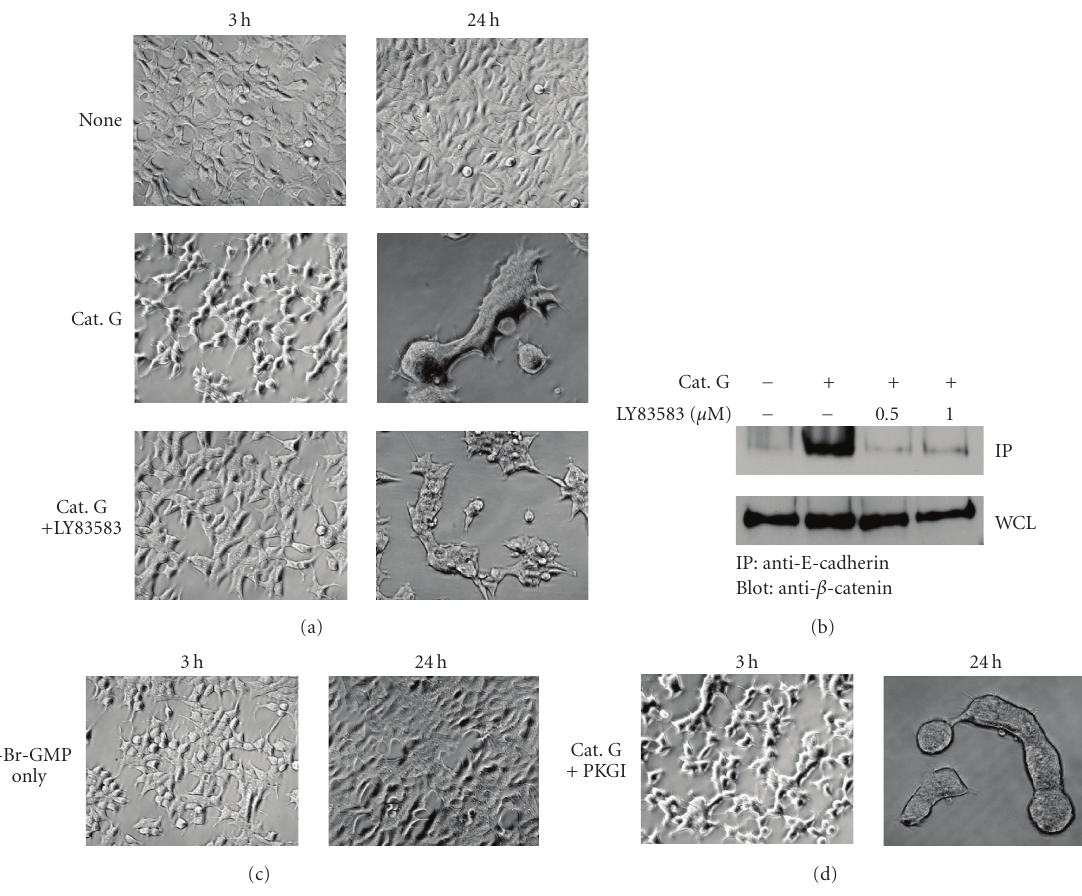
Figure 7: Guanylyl cyclase inhibitor LY83583 has an inhibitory e ff ect on cathepsin G-promoted E-cadherin-mediated cell-cell adhesion. MCF-7 cells were incubated in 5% FBS-containing medium on fibronectin for 24 hours. Cathepsin G-induced cell condensation was analyzed at the original magnification: × 200. (a) After washing, adherent cells were treated with cathepsin G in the absence or presence of 1 μ M LY83583 for 24 hours. Cells were then analyzed by phase-contrast microscopy at 3 hours and 24 hours. (b) After washing, adherent cells were treated with cathepsin G in the absence or presence of LY83583 for 3 hours. The immunocomplexes were then analyzed by immunoblotting using an anti- β -catenin antibody. (c) Adherent cells were treated with 1 μ M 8-Br-cGMP, and cells were then analyzed by phase-contrast microscopy at 3 hours and 24 hours. (d) After washing, adherent cells were treated with cathepsin G in the absence or presence of 1 μ M PKGI for 24 hours. Cells were then analyzed by phase-contrast microscopy at 3 hours and 24